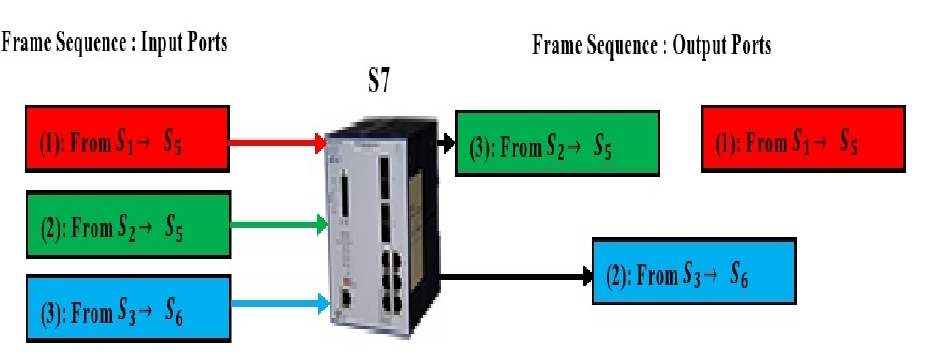
Figure 5. Switching frame sequence part